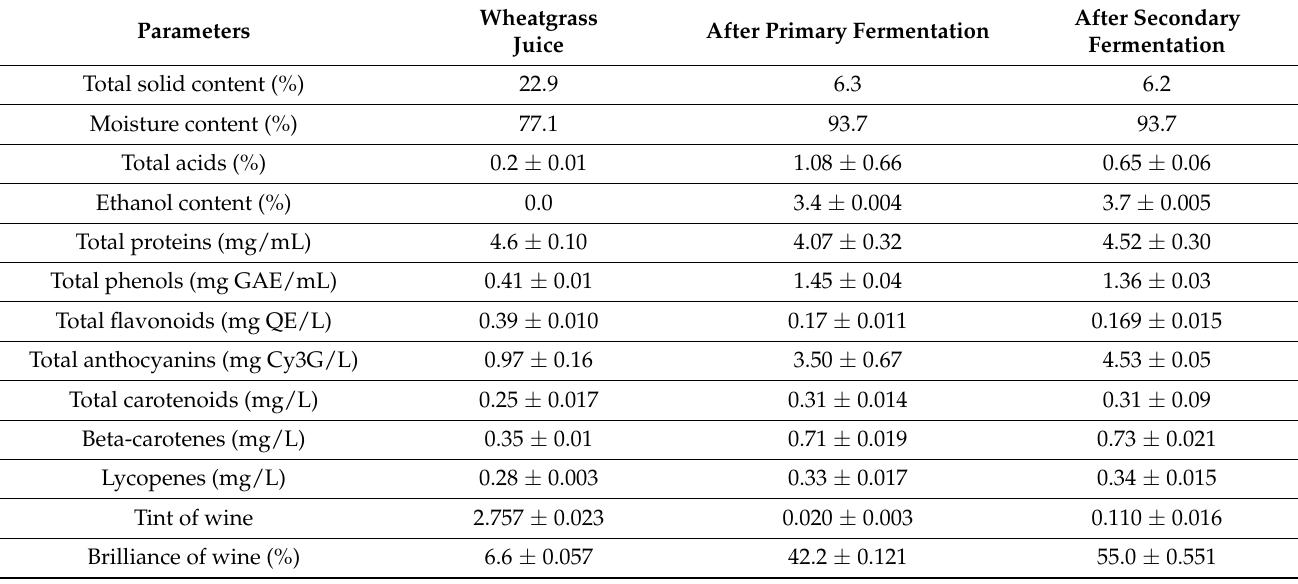
Table 1. Biochemical properties of fermented wheatgrass